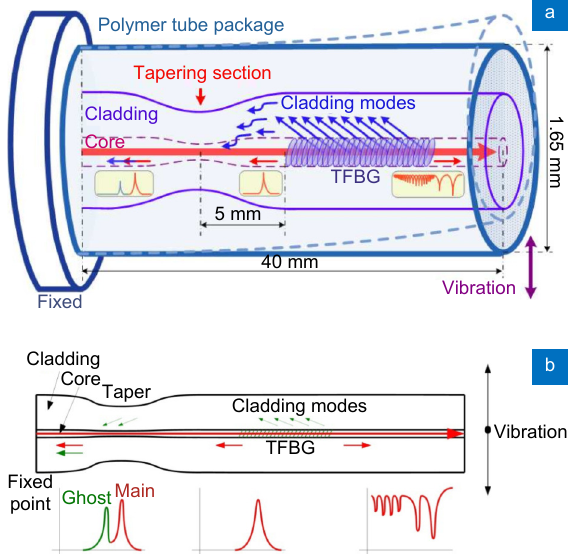
Fig. 14 | ( a ) A compact TFBG based accelerometer. ( b ) Another TF- BG based accelerometer. Figure reproduced from: (a) ref. 5 (b) ref. 71 , Optical Society of America.